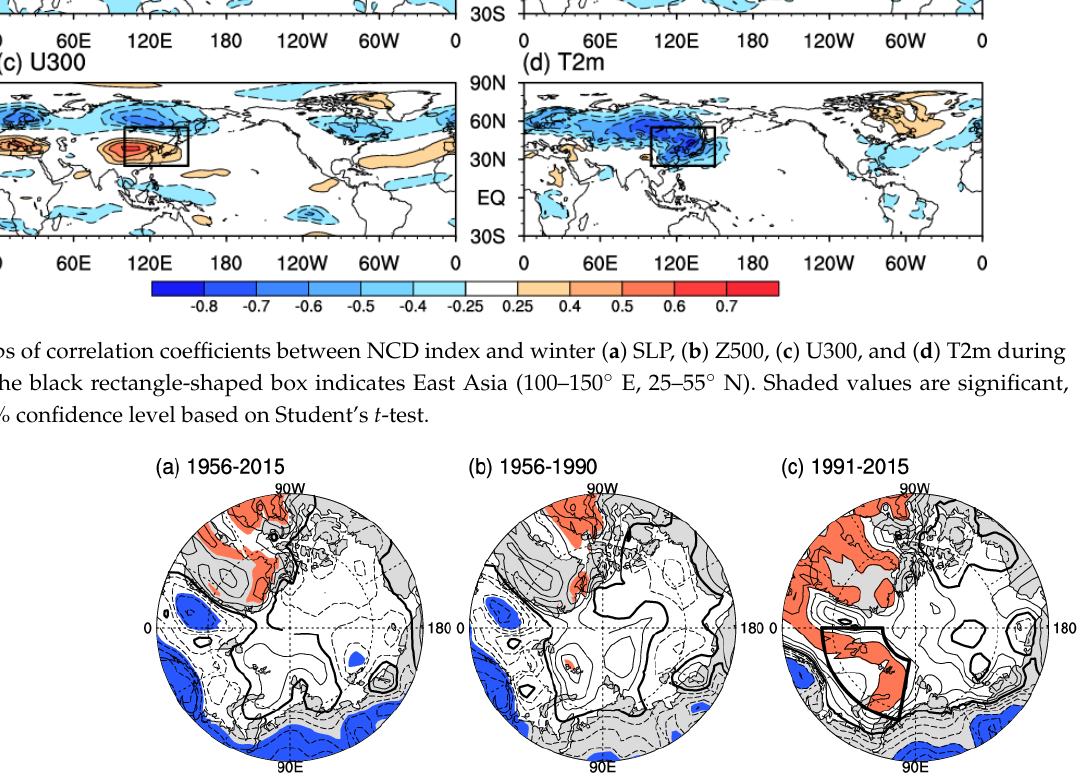
Figure 6. Maps of correlation coefficients between NCD index and winter T2m (65–90° N) during ( a ) 1956–2015, ( b ) 1956–1990, and ( c ) 1991–2015. CI is 0.1, the black fan-shaped box in c indicates the Arctic key region (0–80 ◦ E, 73–84 ◦ N), shaded values are significant, exceeding 95% confidence level based on Student’s t